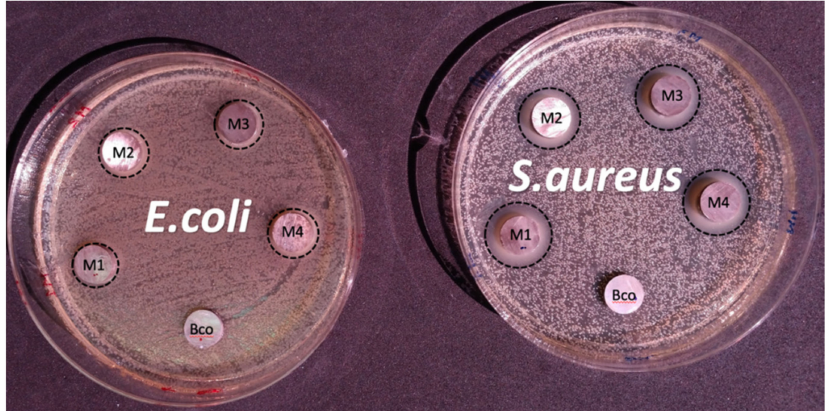
Figure 15. E. coli and S. aureus bacteria growth of on Mg-Ca0.3: bare surface (B); Ag-NPs deposits on Mg-Ca0.3; M1 (10 − 3 M, 1 min), M2 (10 − 3 M, 3 min), M3 (10 − 3 M, 6 min) and M4 (10 − 2 M, 1